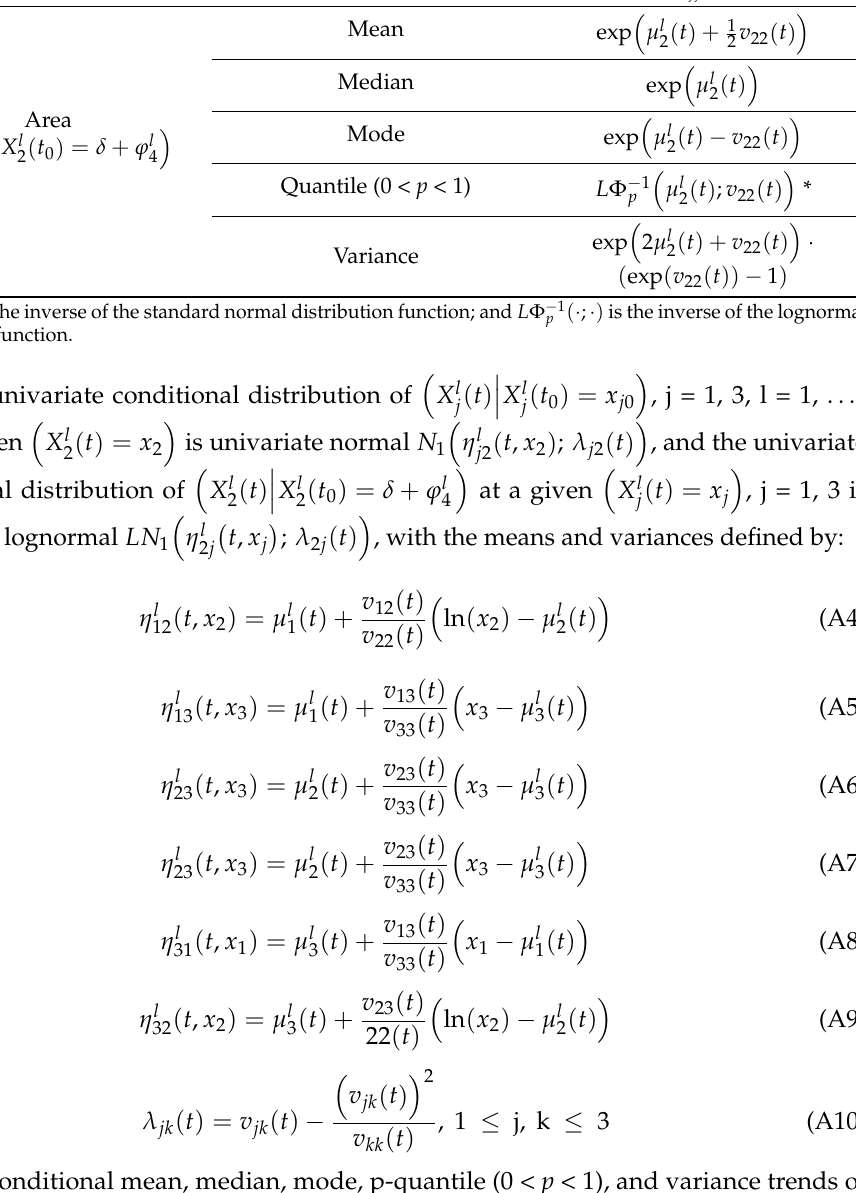
Table A2 represent the cumulative growth of the diameter, area, and height attained by a tree at any particular age and any particular value of additional explanatory variable (such as diameter, area, and